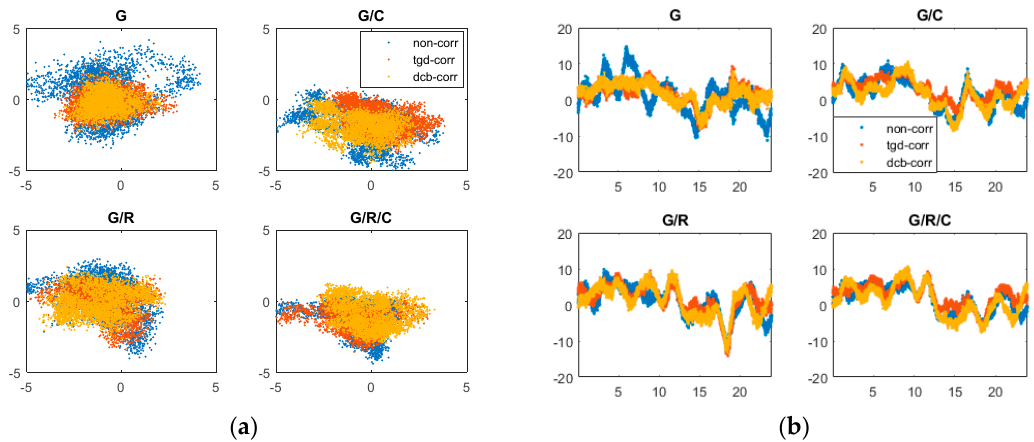
Figure 2. Horizontal ( a ); and vertical ( b ) positioning error scatters of b1 SPP with different schemes in four different constellation combinations. ( a ) For each plot, the horizontal and vertical axes represent, respectively, the N and E component error (unit: m). ( b ) For each plot, the horizontal and vertical axes represent, respectively, the universal time (unit: h) and the positioning error of up component error (unit: m). Sensors 2017 , 17 , 602